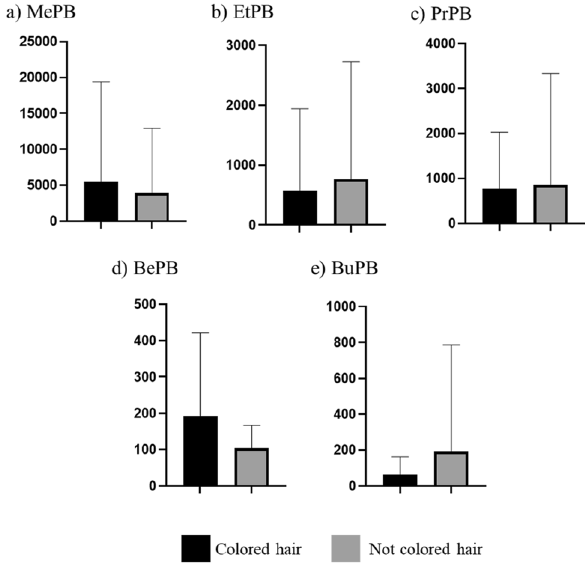
Figure 4. Mean concentration levels (± SD) of parabens in persons with colored hair and natural hair color.